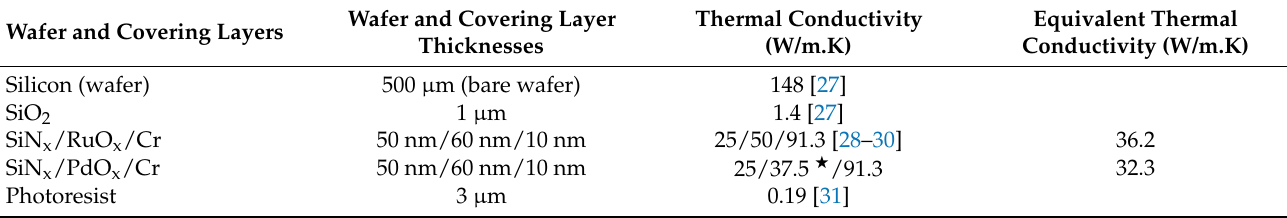
Table 1. Thermal conductivity values of the covering layers used in the preparation of Si-wafers before the integrated reactive multilayer systems (iRMS) deposition. Wafer and Covering Layer Thermal Conductivity Equivalent Thermal Wafer and Covering Layers Thicknesses (W/m.K) Conductivity (W/m.K)